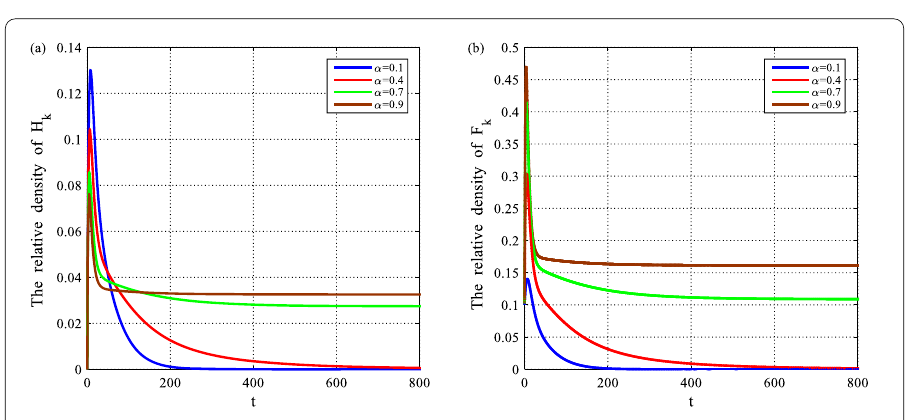
Figure 6 The density of H 200 and F 200 under different α